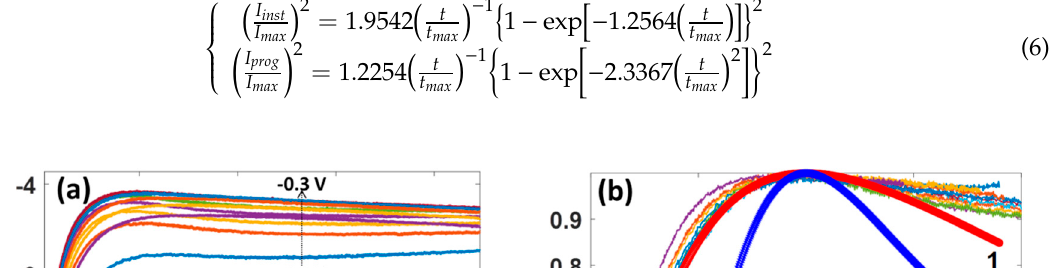
Figure 5. Plots of the current (recorded at the different deposition potentials: from − 0.2 V to − 0.26 V) as a function of the inverse square root of the time for electrodeposition of mercury on the epitaxial graphene from 0.1 M HClO 4 + 0.1 mM Hg 2+ electrolyte solution.